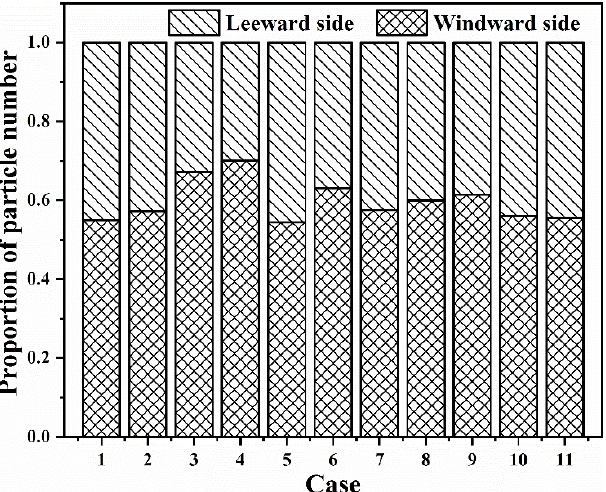
Figure 15. Number distribution of deposited particles on the fiber surface with different particle sizes, aspect ratios, packing densities, and inlet flow velocities.